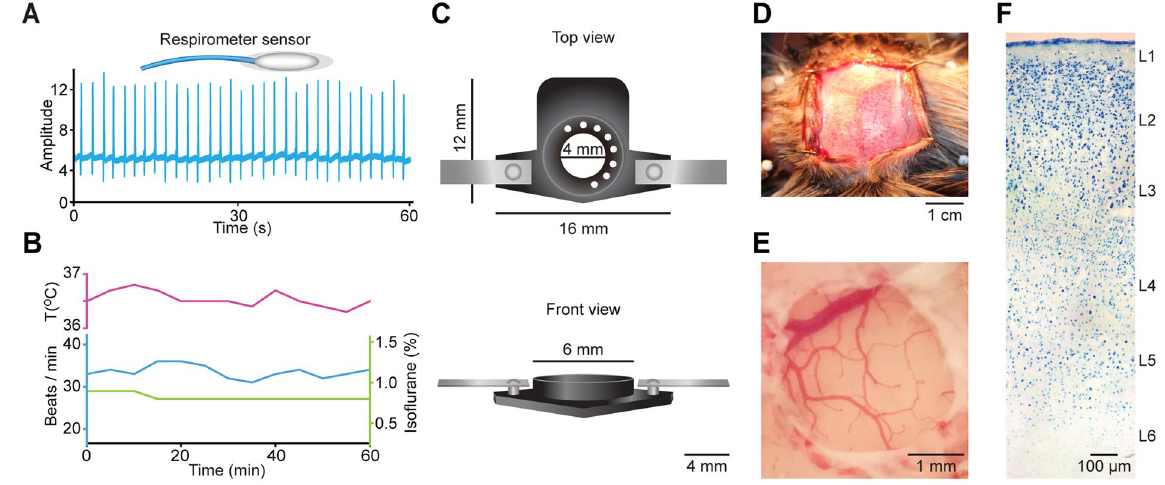
Figure 1. The Marmoset’s physical condition and preparation for two-photon Ca 2 + imaging in marmoset cortex in vivo . ( A ) Respiration rate recording. Upper, Cartoon of the sensor of respirometer. Lower, respiration activity over a 60 sec recording period. (B) Body temperature (upper, purple), breathing rate (middle, blue) and isoflurane concentration (lower, green) over a 60 min recording period. (C) Cartoon of the custom-made chamber (black part: length 16 mm, width 12 mm, innerdiameter 4 mm; outer diameter 6 mm; height 5 mm) and holder (grey part, length 10 mm for one side). Upper, top view. Lower, front view. ( D ) Exposed skull. ( E ) Exposed primary somatosensory cortex. ( F ) Nissl staining of the marmoset neocortex, showing all 6 layers